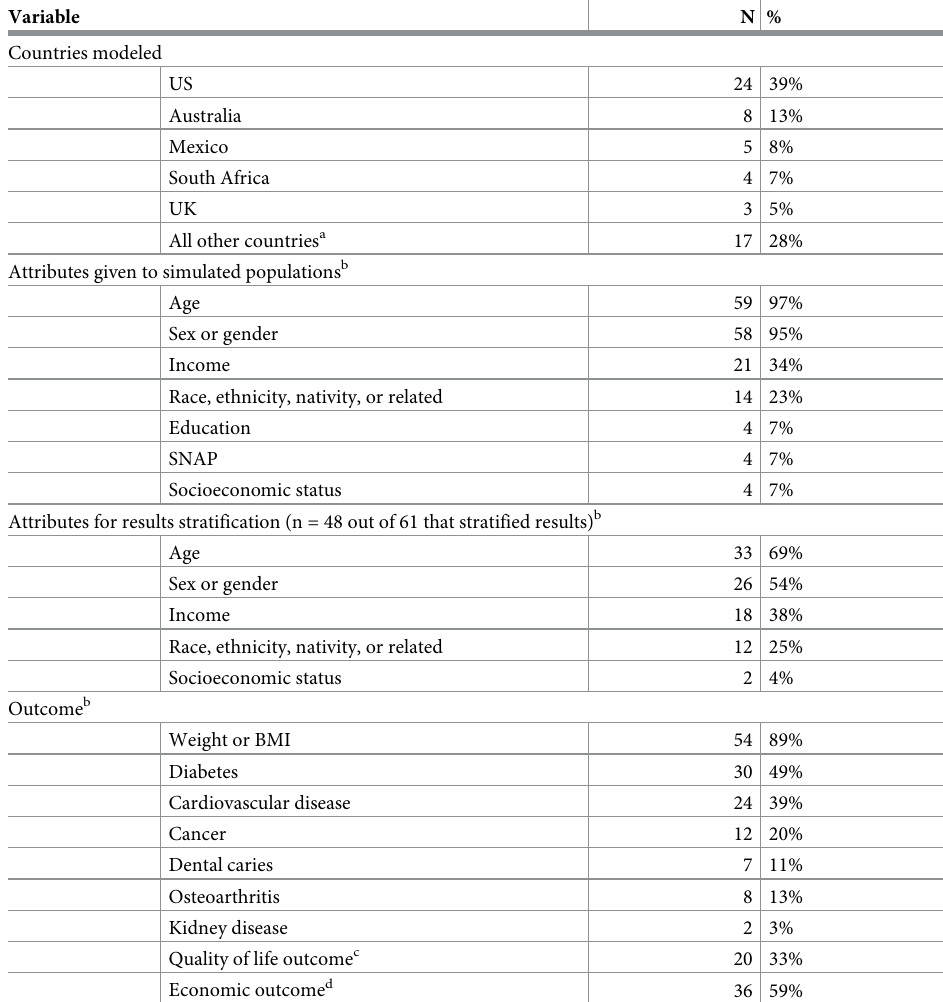
Table 1. Populations and outcomes modeled in included studies (n = 61). Variable N % Countries modeled